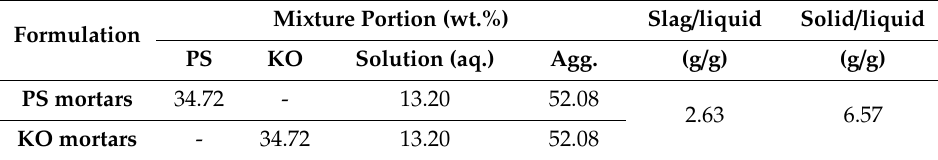
Table 1. Mortars mixture composition and slag-to-liquid and solid-to-liquid mass ratio. Formulation